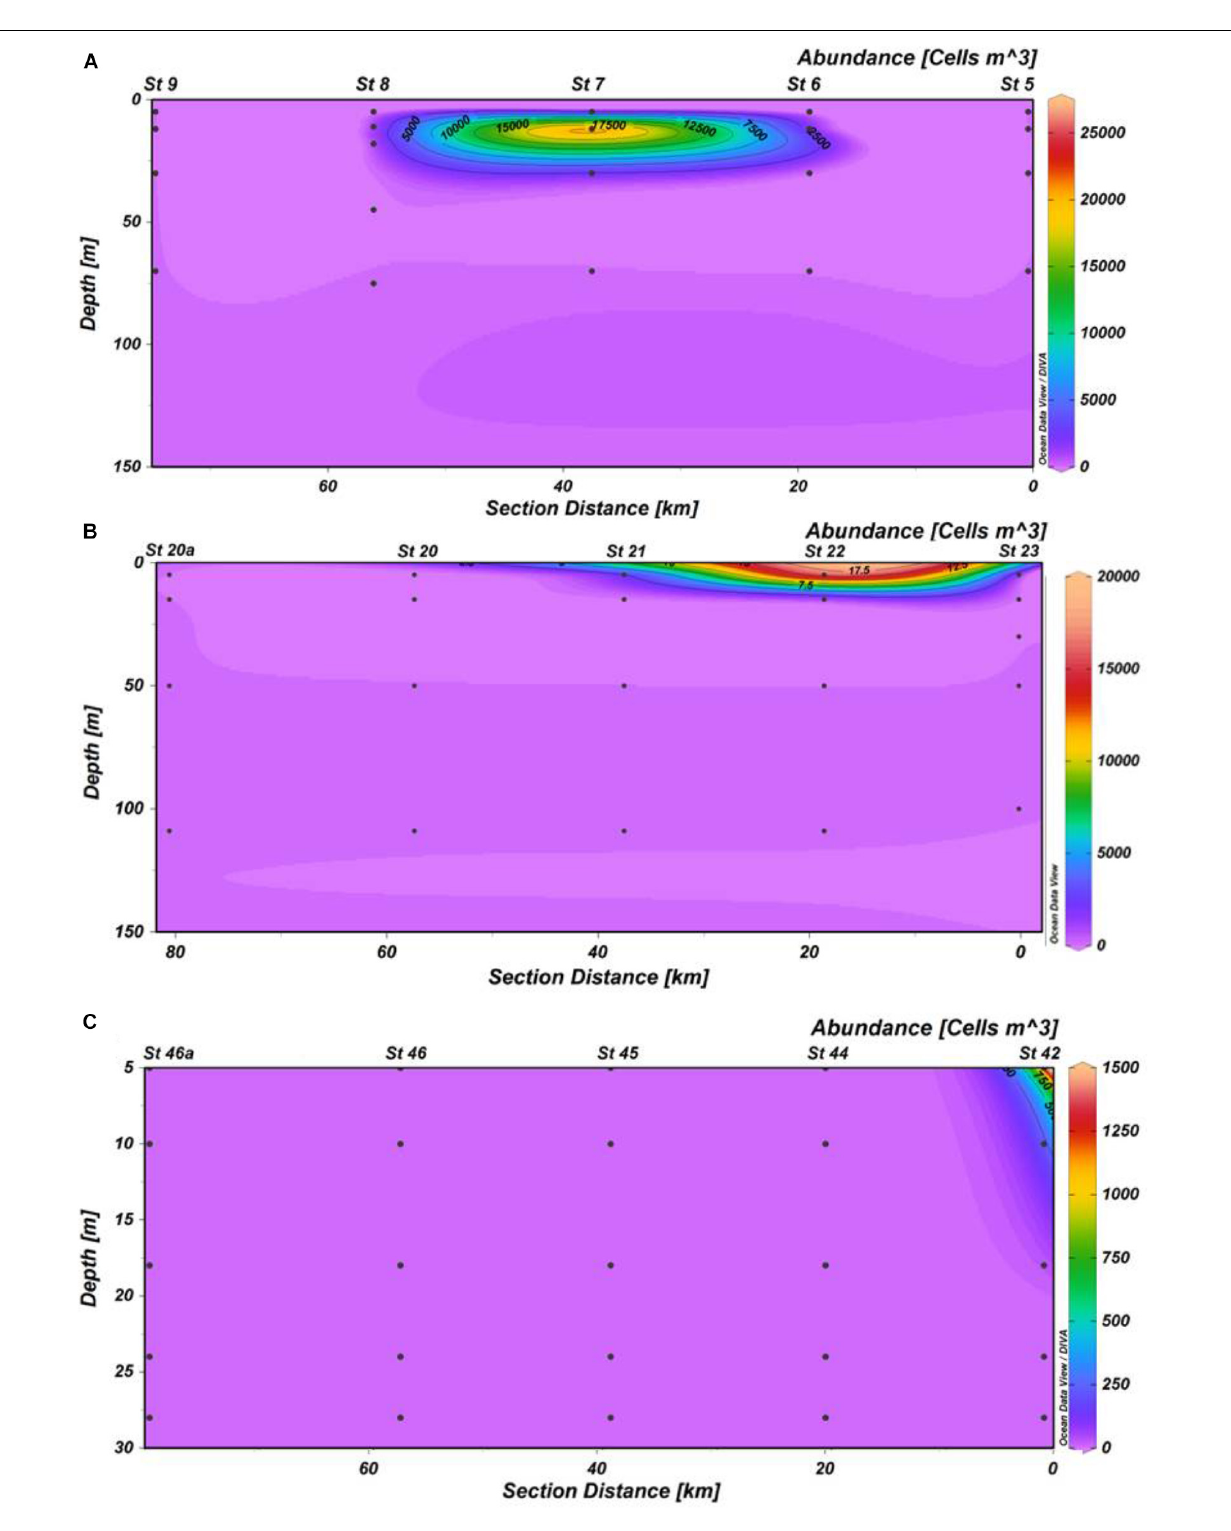
Frontiers in Marine Science |